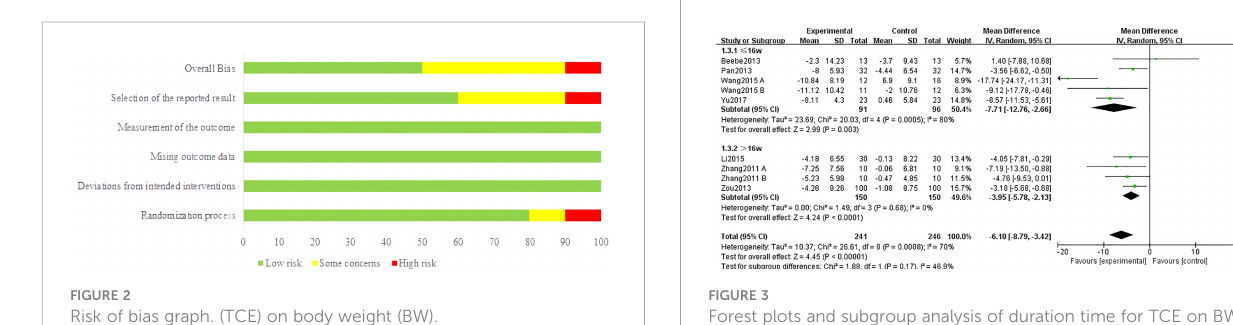
FIGURE 2 Risk of bias graph. (TCE) on body weight (BW).